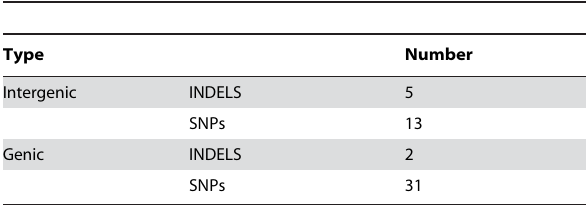
Table 4. Summary of divergence between T. pallidum and T. paraluiscuniculi